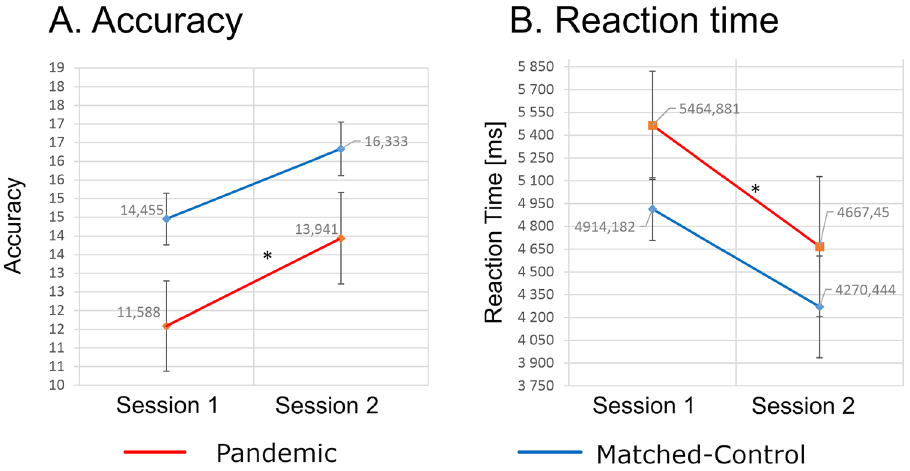
Figure 5. Accuracies and reaction times in transitive reasoning tasks performed in Session-1 and 2. Mean accuracies in difficult task variant ( A ) and mean reaction times in easy task variant ( B ). Stars above lines joining the results of Sessions-1 and Session-2 denote significant differences ( p < 0.05) of Chi 2 post-hoc test followed by Friedman’s non-parametric ANOVA. Created using JASP 0.14.1 (https:// jasp- stats.